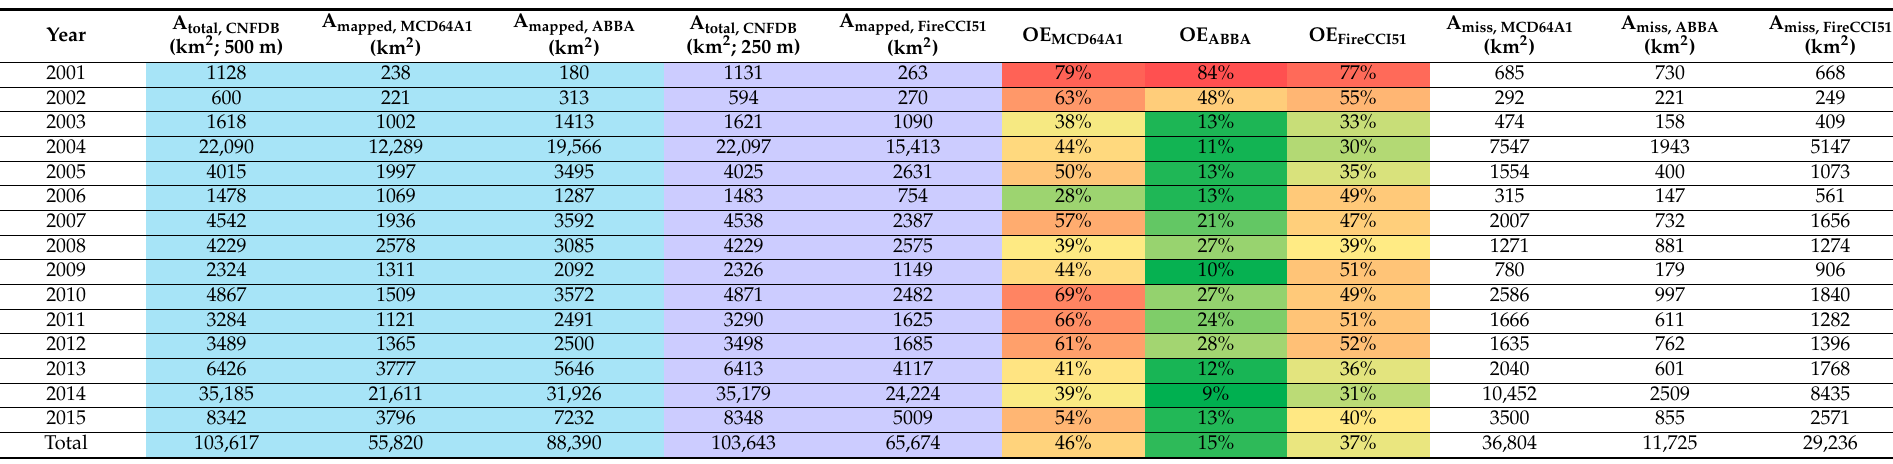
Table 4. Results of the omission error analysis that was based on the CNFDB dataset in Canada. The cells that are highlighted in blue and purple represent the comparisons made at the 500 m and 250 m nominal resolutions, respectively. The cells that contain OE values are colored, with green to red indicating low to high OE